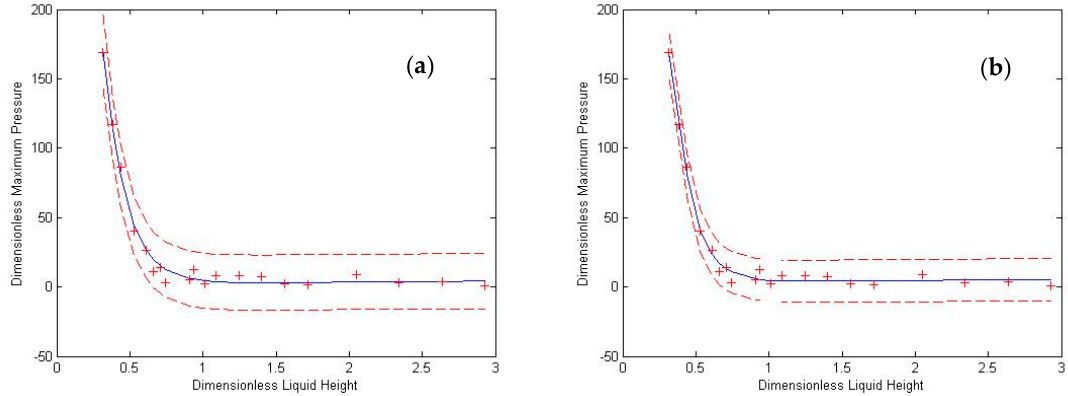
Figure 15. Graph of the proposed equation for dimensionless pressure plotted against dimensionless liquid height with 95% confidence bounds for ( a ) Single-Gene and ( b ) Multi-Gene modes.